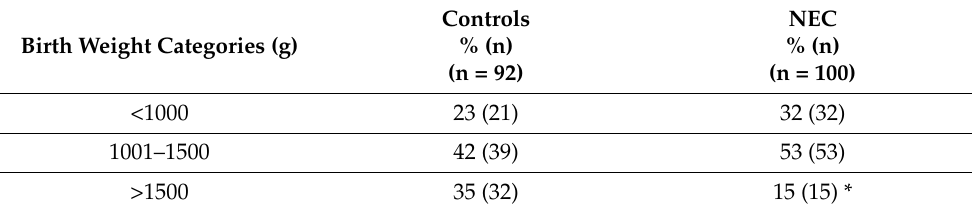
Table 2. Birth weight in Control and necrotizing enterocolitis (NEC)